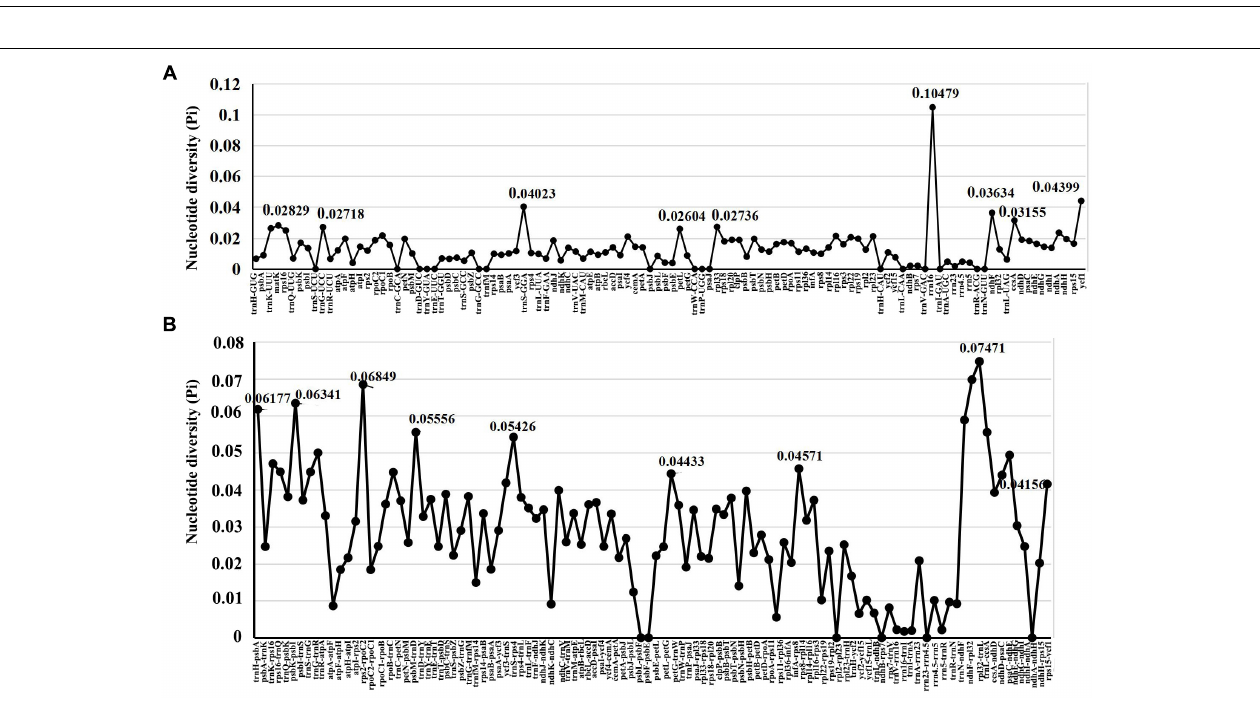
FIGURE 4 | Comparative analysis of the nucleotide diversity (Pi) values among four Echinacanthus chloroplast genomes. (A) Coding regions. (B) Non-coding regions. X -axis: name of the regions; Y -axis: nucleotide diversity (Pi).